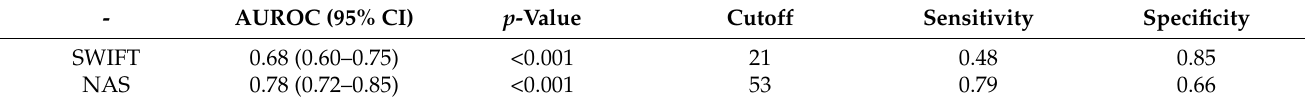
Figure 2. Area under the receiver operating characteristic curve for the NAS and SWIFT scores calculated at the time of intensive care unit discharge. NAS, Nursing Activities Score; SWIFT, Stability and Workload Index for Transfer. Table 2. Comparison of predictive power and clinical utility of SWIFT and NAS of ICU readmission.